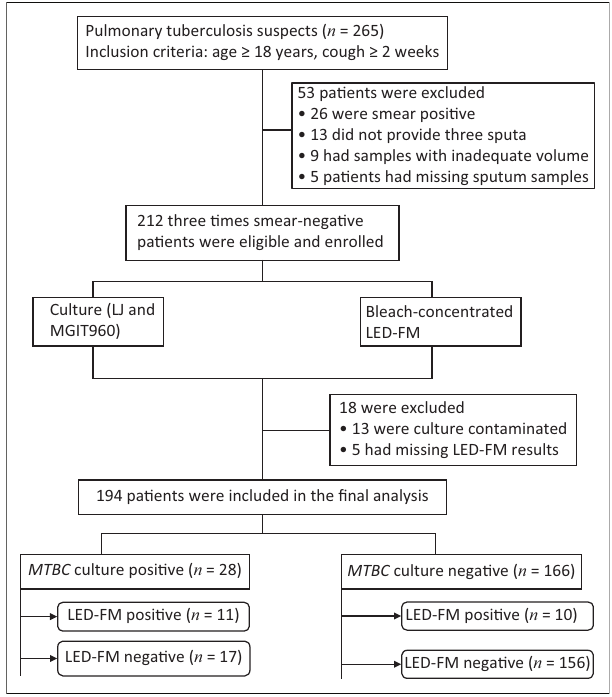
FIGURE 1: Flow diagram of patient recruitment, sample processing and diagnostic test results, Ethiopia,